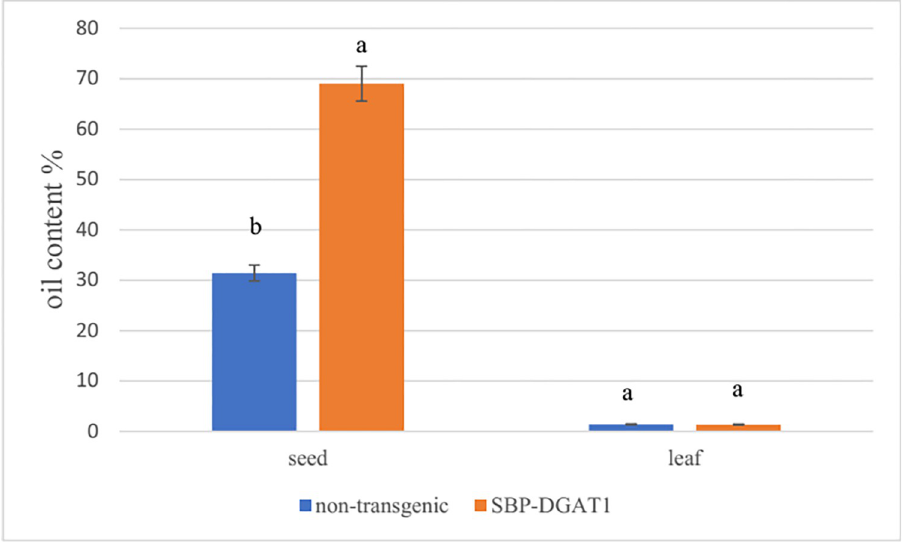
Fig 8. Functional impact of SBP promoter on the seed and leaf oil content (%) of transgenic (SBP-DGAT1) and non-transgenic tobacco lines. Mean values with different letters are significantly different by one-way ANOVA (P < 0.01), n =